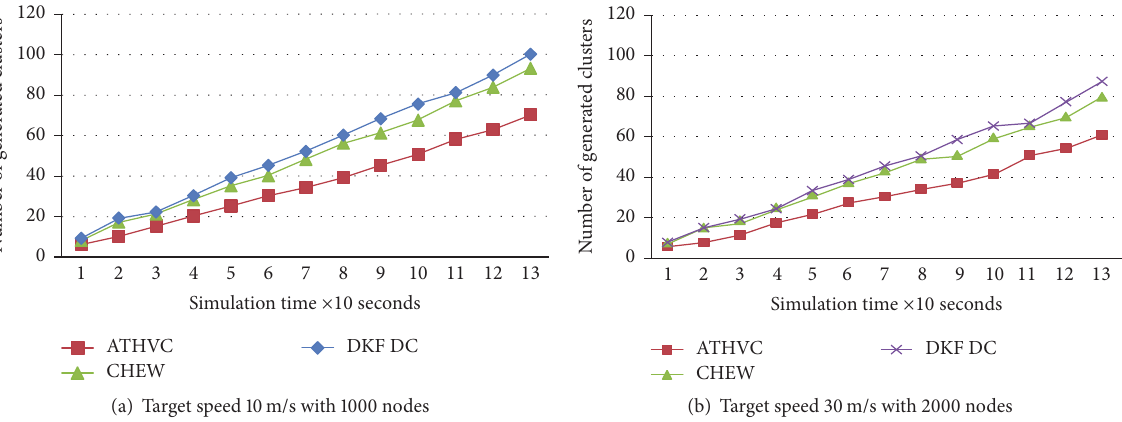
Figure 9: The number of clusters based on the simulation time.